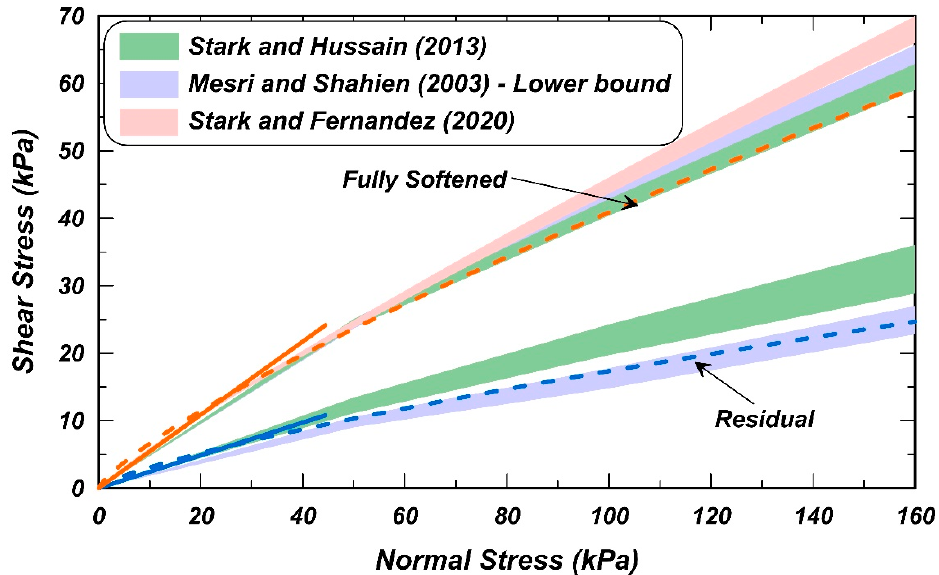
Figure 8. Comparison of the data from this study with previous studies for both fully softened and residual shear strengths